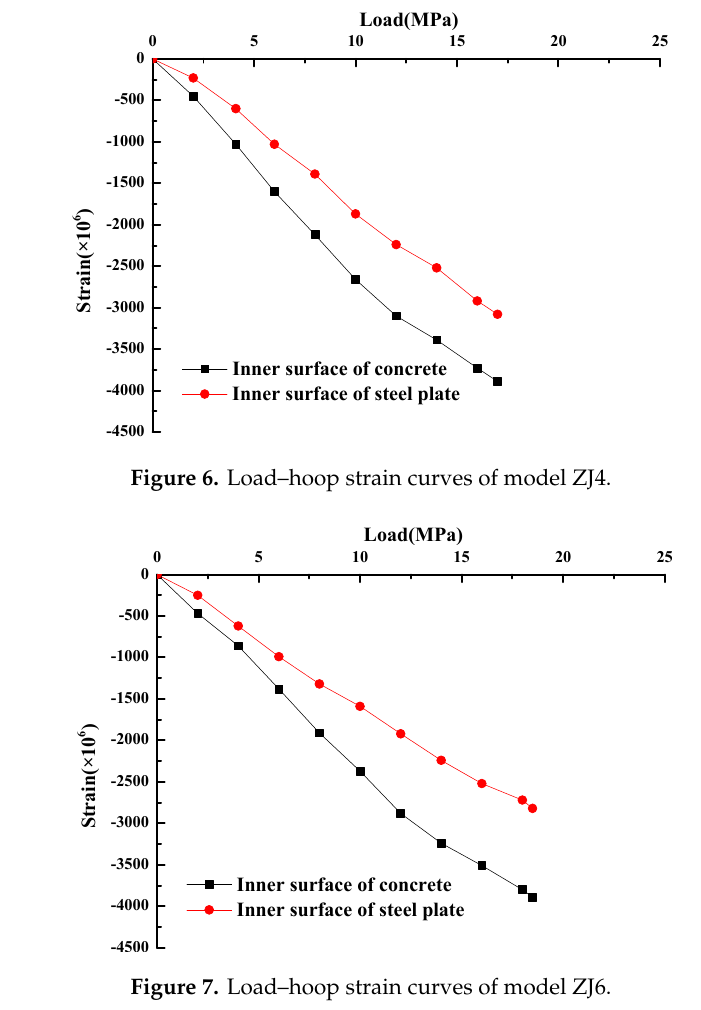
Figure 4. Loading device for simulation testing. To determine the stress–strain characteristics during the loading process, each specimen of the shaft lining model was divided vertically into two layers, and four measuring zones were set equidistantly along the circumferential direction in each layer. In each measuring zone, a measuring point was set on each of the surface of the inner steel plate, the surface of the outer steel plate, and the inner side of the concrete. At each measuring point, a strain gauge was placed in each of the transverse and longitudinal directions. A strain brick was embedded in the concrete on the inner side of the concrete layer. In addition, a hydraulic sensor installed in the loading system for the high- performance shaft lining test was also used to measure the load applied to the specimen and its ultimate bearing capacity. 5. Results and Discussion